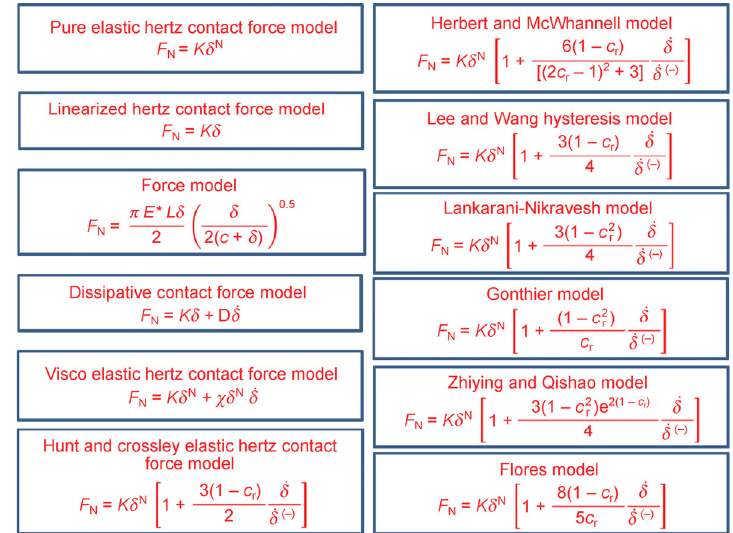
Fig. 10 Equations for the different contact models [102, 104, 108].